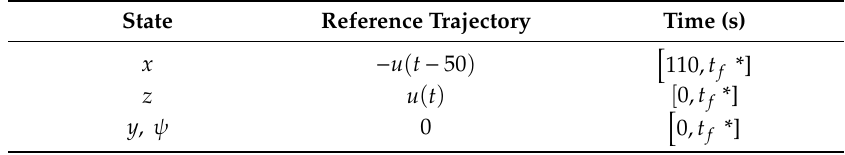
Table 12. Switching formation topology input signals.